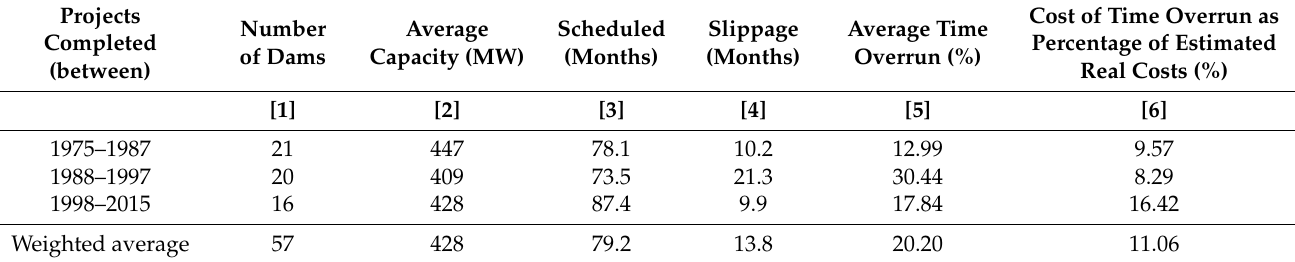
Table 10. Comparison of cost of time overruns for different